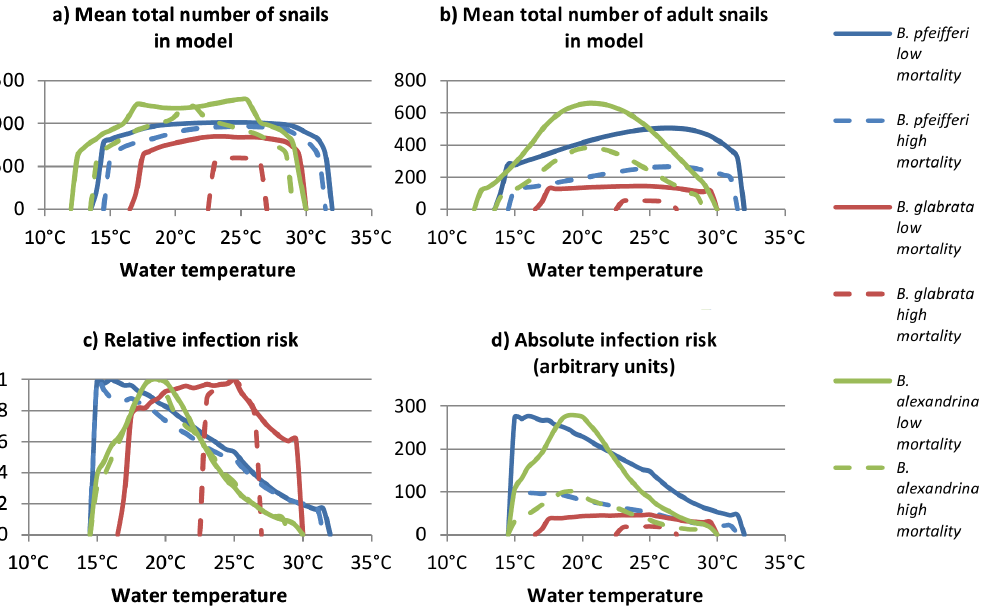
Figure 3. Number of snails and relative infection risk, with high and low mortality rates. a) Mean total number of snails in the model. b) Mean total number of adult snails in the model. c) Infection risk, relative to the maximum risk for the same snail species with the same mortality rates. d) Absolute infection risk (arbitrary units). Blue lines show B. pfeifferi , red lines show B. glabrata and green lines show B. alexandrina. Solid lines show results with a low mortality rate and dashed lines with a high mortality rate.